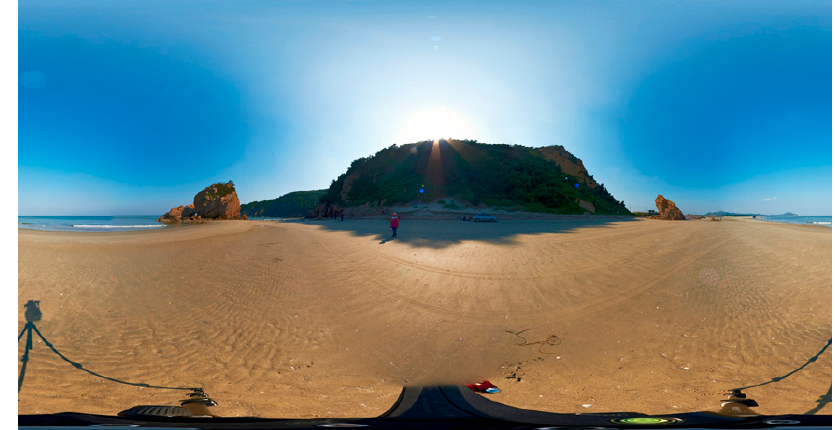
Figure 3. Completed Stitched Image.